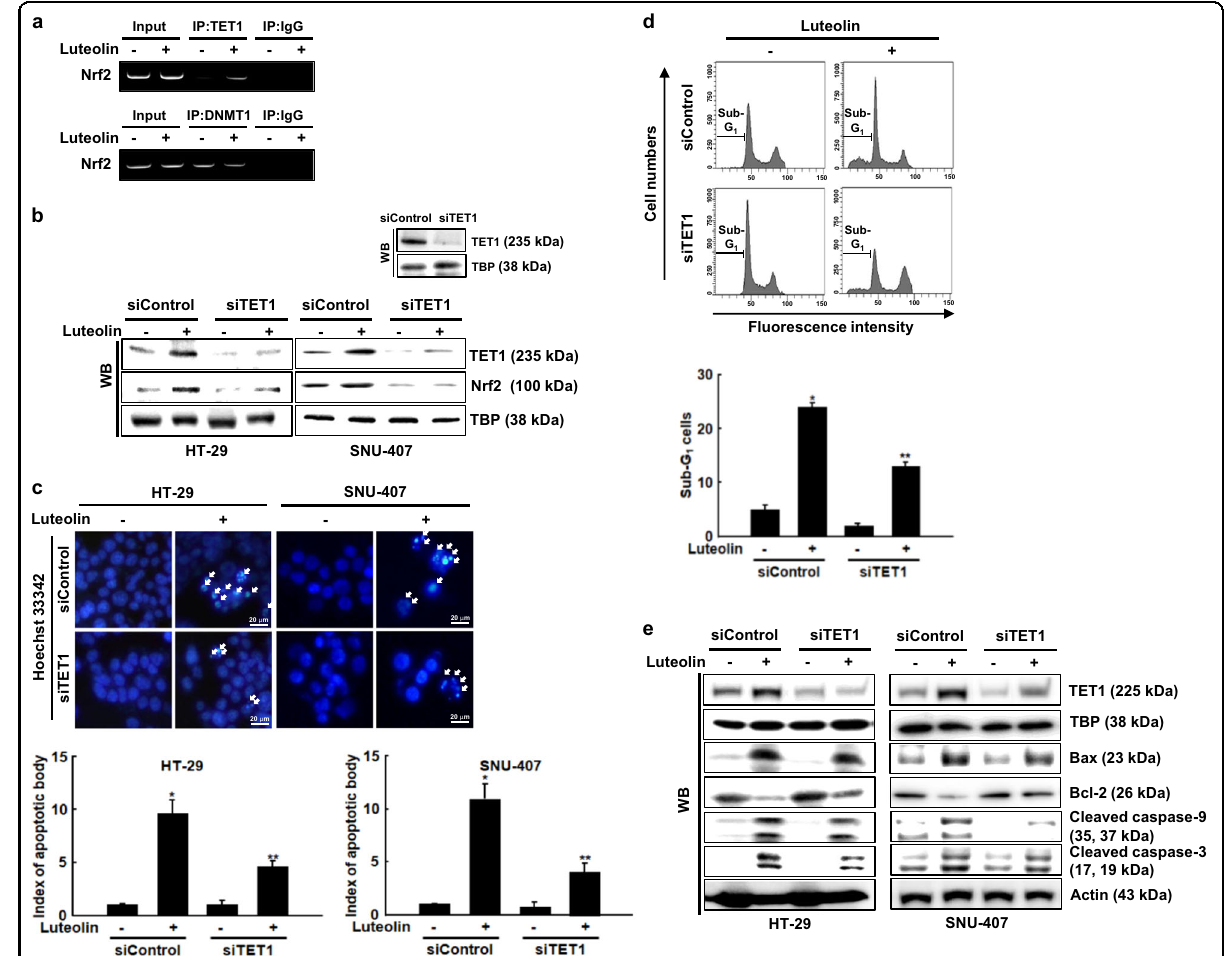
Fig. 5 TET1 upregulates Nrf2 in luteolin-treated colon cancer cells. a ChIP was performed using anti-TET1 and anti-DNMT1 antibodies and primers designed to amplify the Nrf2 promoter region. Bands indicate the levels of TET1 and DNMT1 bound to the Nrf2 promoter region. Inputs represent ampli fi cation of total DNA from whole-cell lysates. Cells were transfected with control or TET-targeting siRNA for 24 h. b Nrf2 protein expression was determined using western blotting. c Apoptotic body formation was observed using a fl uorescence microscope after cells were stained with Hoechst 33342. Arrows indicate apoptotic bodies; * p < 0.05 and ** p < 0.05 compared with control and luteolin-treated cells, respectively. d Apoptotic sub-G 1 DNA content was detected using fl ow cytometry after cells were stained with PI; * p < 0.05 and ** p < 0.05 compared with control and luteolin-treated cells, respectively. e Cell lysates were electrophoresed, and Bax, Bcl-2, active caspase-9, and active caspase-3 proteins were detected using speci fi c